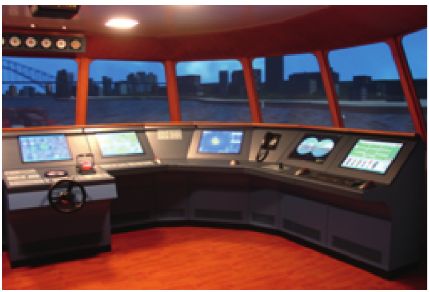
Figure 7: Simulation experiment